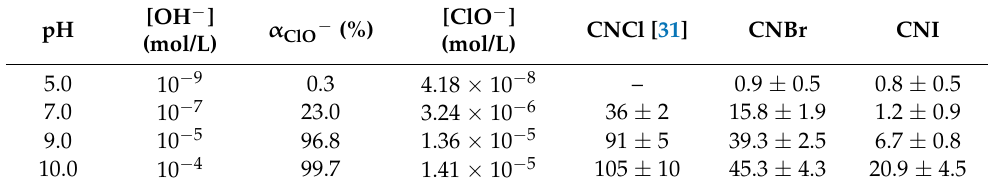
Table 3. Reaction rate constants for CNXs at different pH values in the presence of chlorine ( k Cl2 , 10 − 5 s − 1 ).